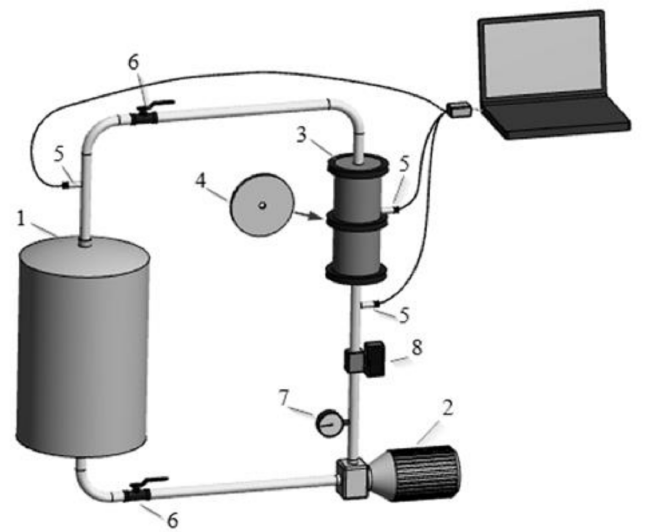
Figure 1. Experimental installation and orifice plate configuration: 1—circulation tank, 2—pump, 3—hydrodynamic cavitation reactor, 4—orifice plate, 5—piezoelectric pressure gauge, 6—valve, 7—manometer, 8—electromagnetic flow